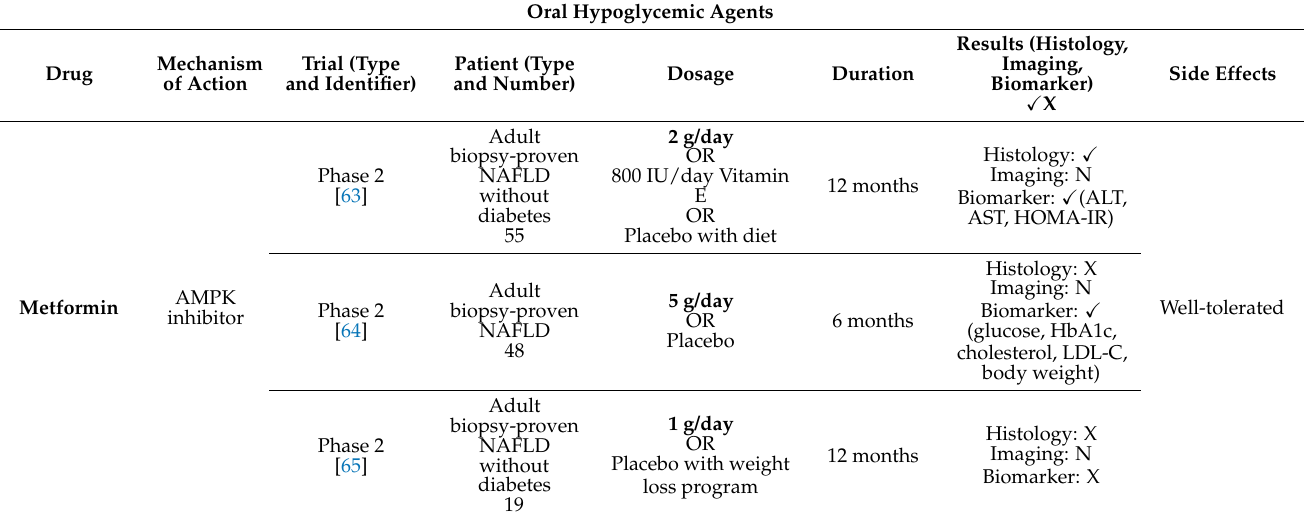
Oral Hypoglycemic